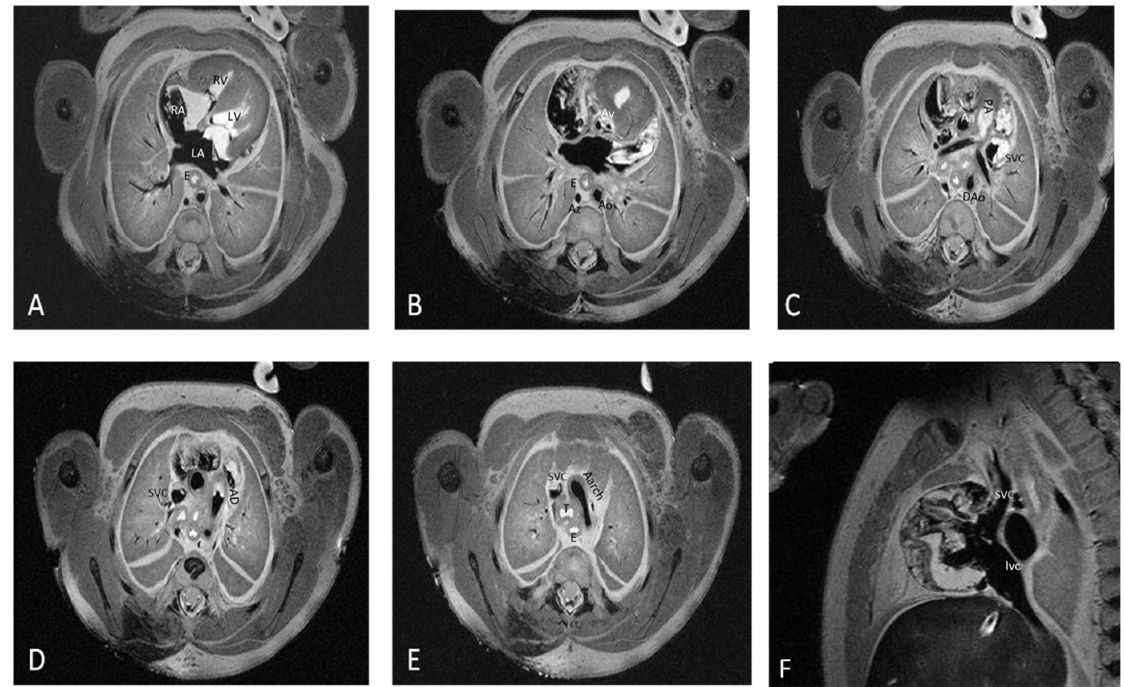
Figure 1. The fourteen cardiac items evaluated using 7T pm-MRI (T2, WI) depicted in a control case. Seventeen weeks of gestation-age fetus resulted from therapeutic interruption of pregnancy due to severe hydrocephaly with normal cardiac imaging evaluation and was confirmed by conventional stereomicroscopic dissection. Transvers section through the mediastinum depicting: ( A ) four chamber view with interatrial and interventricular septum, atrioventricular valves, left atrium (LA), right atrium (RA), left ventricle (LV), right ventricle (RV) and two pulmonary arteries, and esophagus ( E ); ( B ) aortic valve (Av), esophagus ( E ), aorta (Ao), and azygos vein (Az); ( C ) pulmonary artery (PA), ascending aorta (Aa), descending aorta (Dao), and superior vena cava (SVC); ( D ) arterial duct (AD); ( E ) aortic arch (Aarch) and trachea (T); and ( F ) sagittal section through the mediastinum depicting inferior vena cava (IVC) and